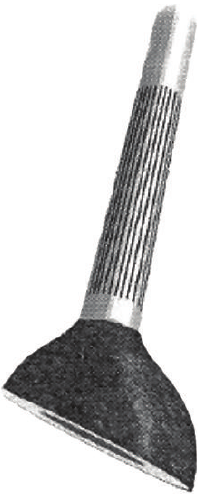
Figure 1: Iliac stem prosthesis.